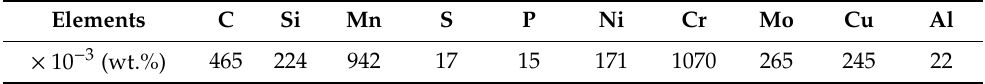
Table 1. Chemical composition of the medium carbon steel 42CrMo4 (AISI 4142).